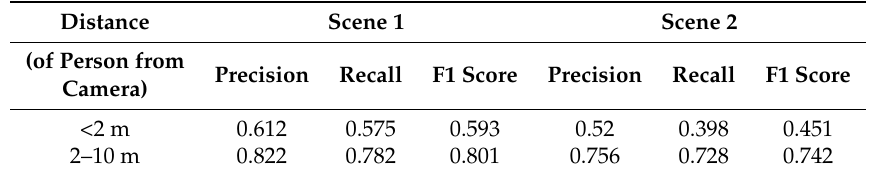
Table 3. Precision and recall evaluation.